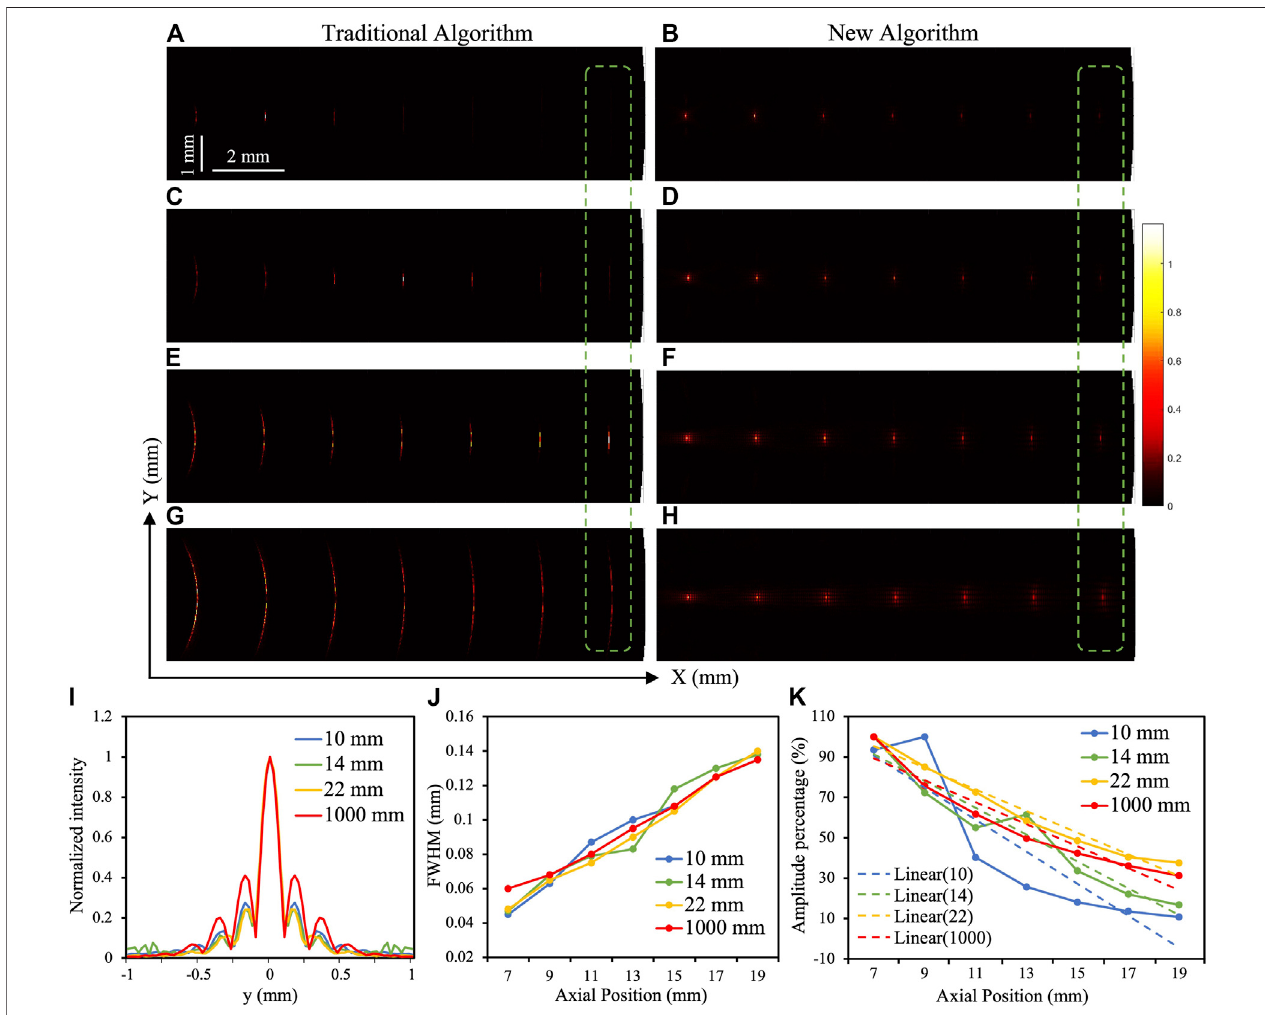
FIGURE 4 | Simulated ultrasonic imaging results in the X – Y direction. (A,C,E,G) The imaging results simulated by traditional USE reconstruction algorithm under focusesof10,14,22,and 1,000 mm, respectively. (B,D,F,H) Theimagingresults simulatedbytheimproved USEreconstruction algorithmunderfocuses of10, 14,22, and 1,000 mm, respectively. (I) The lateral pro fi les for the seventh target (from left to right; at 19 mm) obtained from (B,D,F,H). The blue, green, yellow, and red lines represent the results of 10, 14, 22, and 1,000 mm, respectively. The amplitudes of these lines are normalized to 1 for comparison. (J) The FWHM value of each targets along the Y direction in (B,D,F,H). (K) The contrast curves of seven points under focus of 10, 14, 22, and 1,000 mm, respectively and the linear fi tting curves.